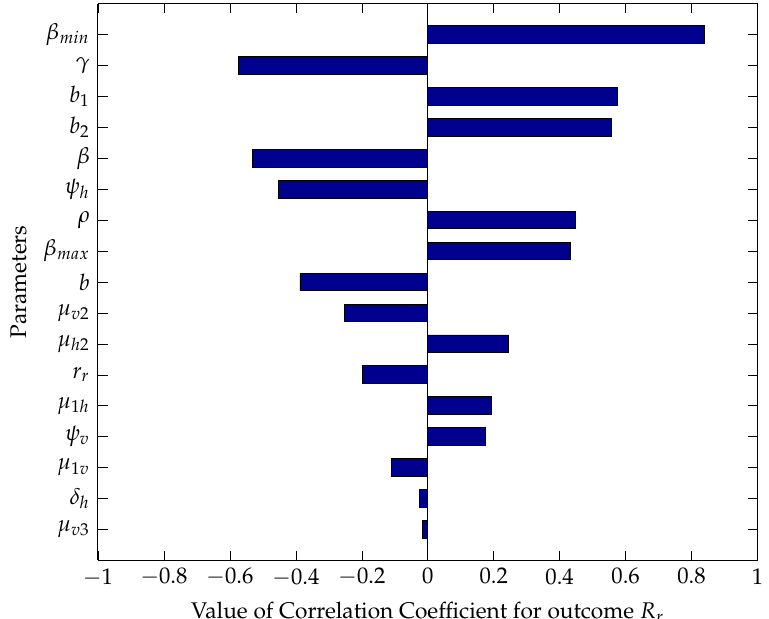
Figure 3. Tornado plot showing the sensitivities of the model parameters affecting the reproduction number for resistant strain R r .